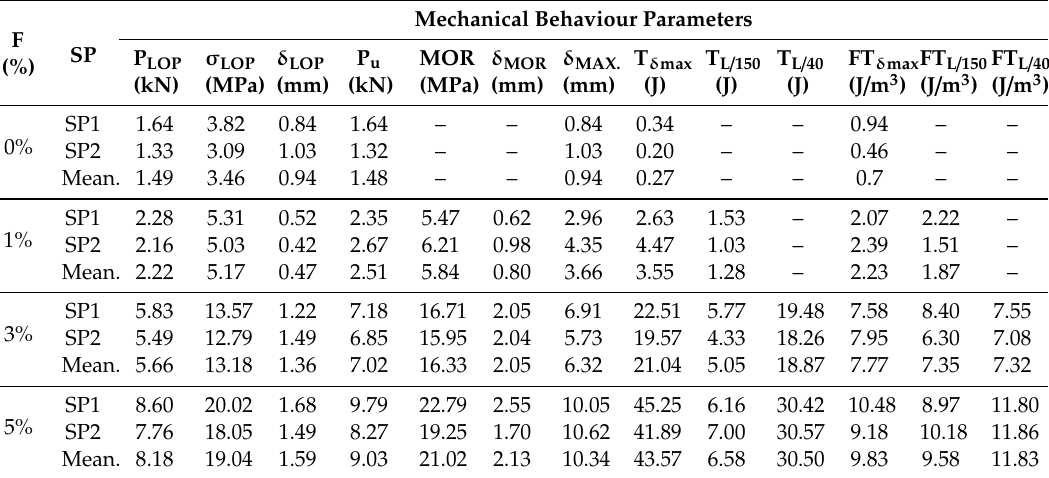
Table 3. Parameters of the mechanical behaviour under